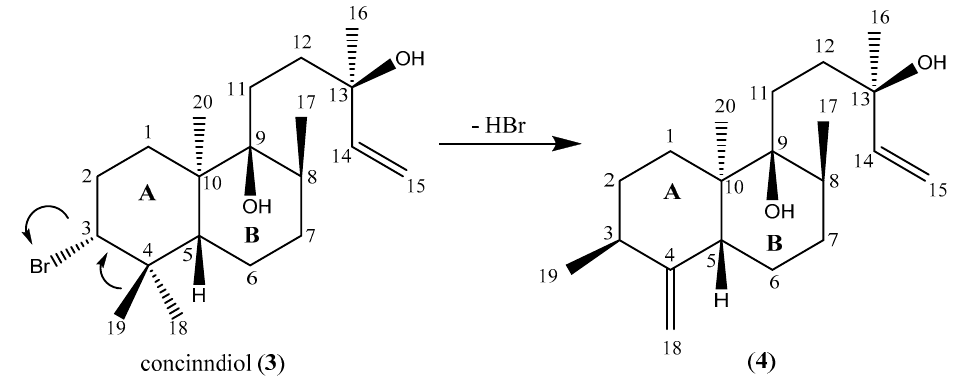
Figure 2. Biosynthetic pathway from concinndiol (compound 3 ) to compound 4 . Table 2. NMR spectroscopic data (400 MHz, acetone- d 6 ) of compounds 3 and 4 .